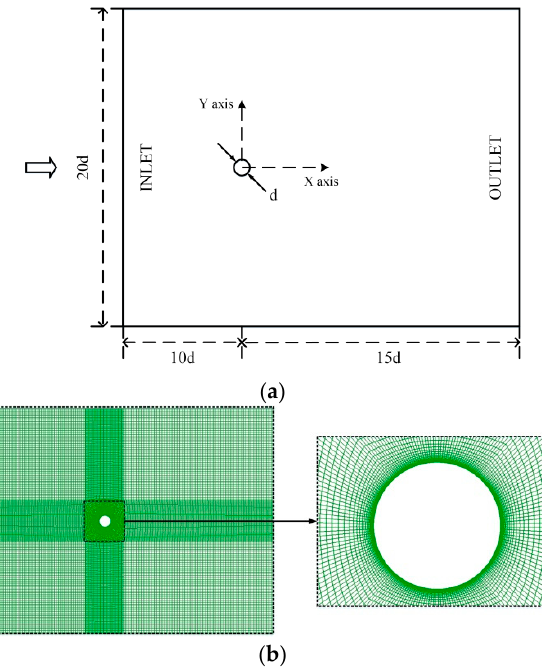
Figure 3. ( a ) Schematic of the 2D computational domain; and, ( b ) the mesh of overall computational domain and enlarge grid around the cylinder.